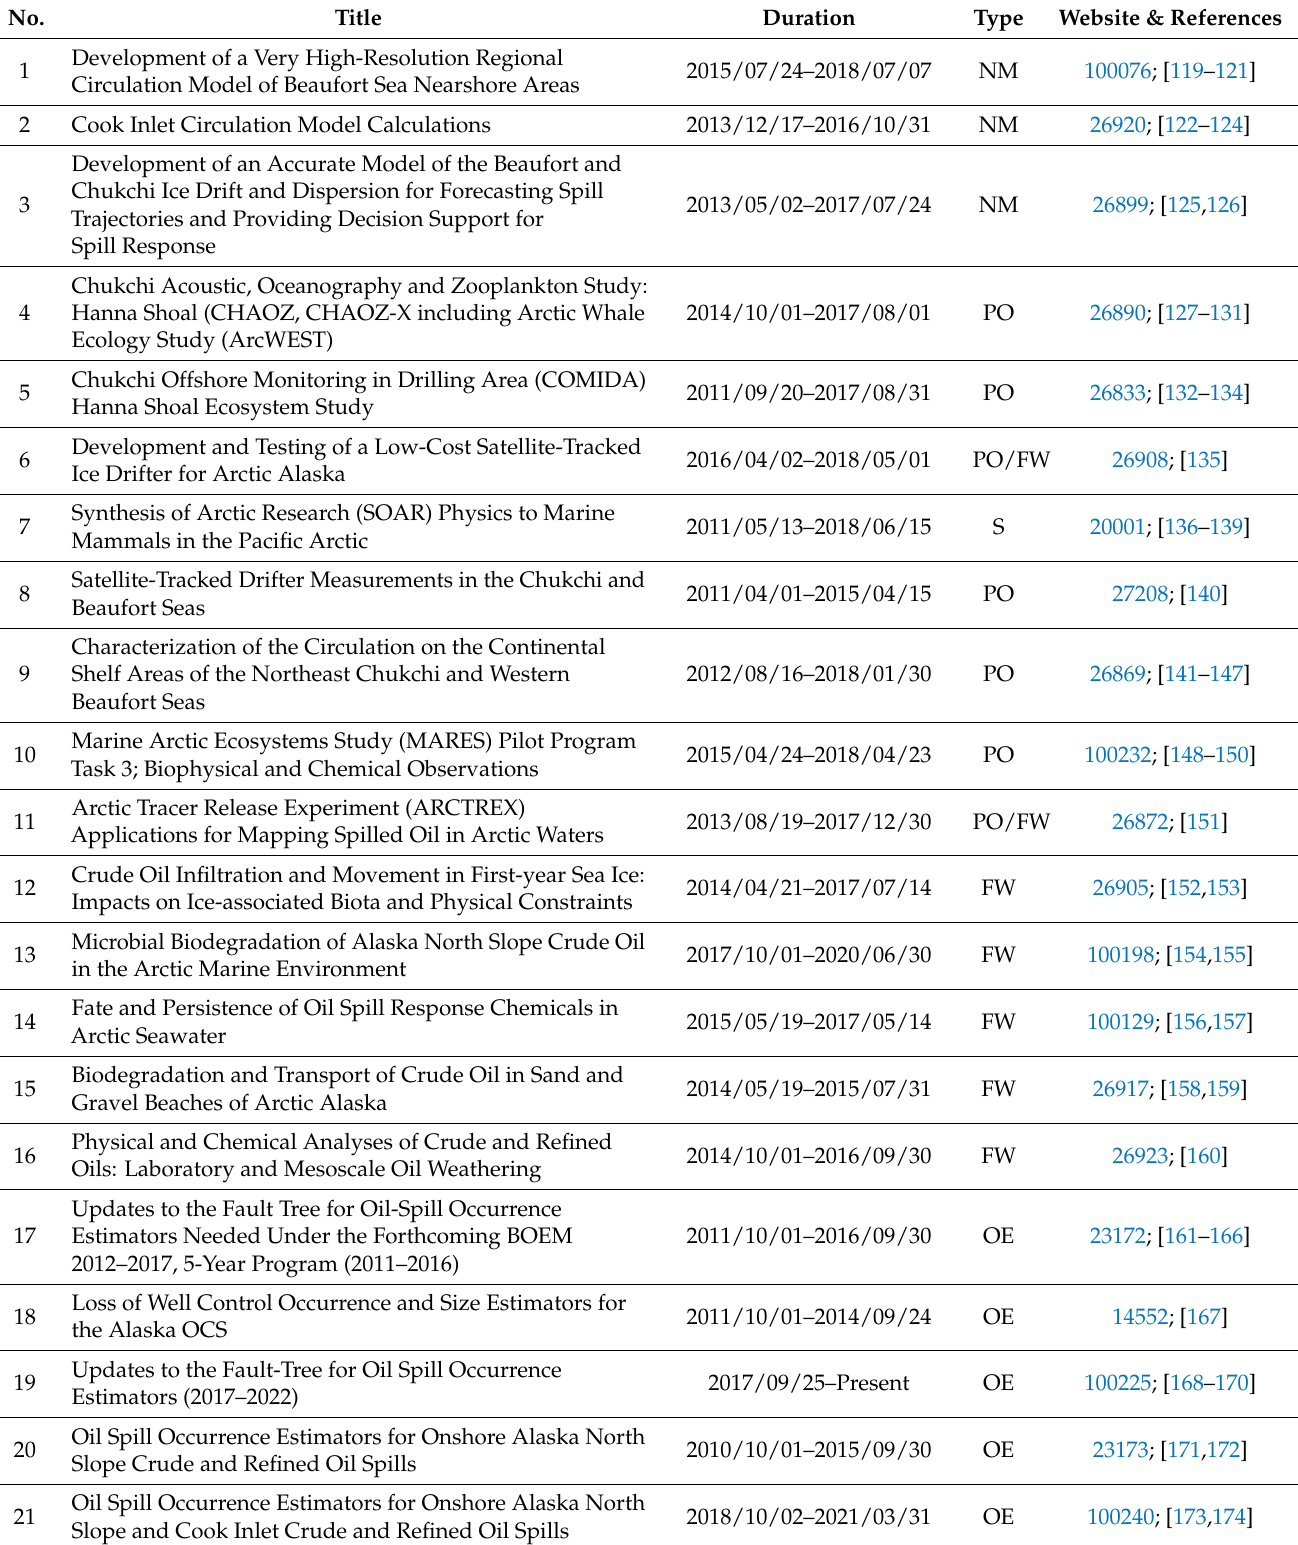
Table 2. Summary of ESP studies supporting oil spill modeling in Alaska since the DWH